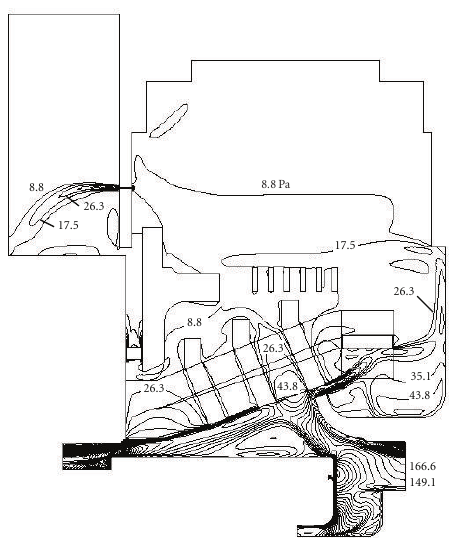
Figure 6: Dynamic pressure contours at the end-winding region.